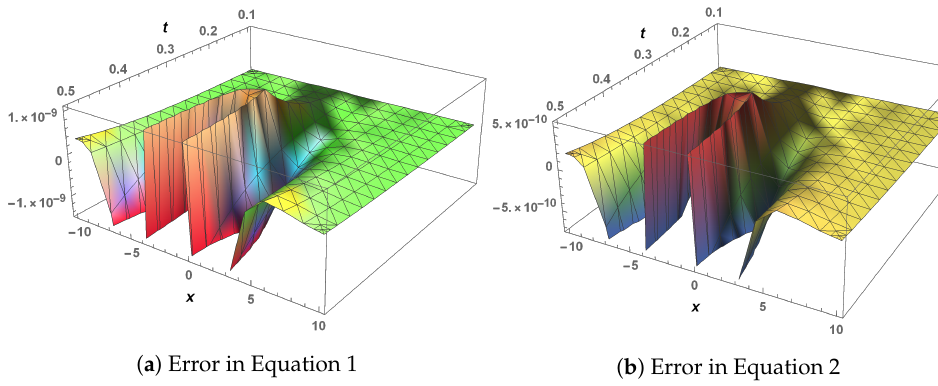
Figure 2. Three-dimensional (3D) errors analysis of Example 1 when β = 1, α = 1 and η = a = 0.5.